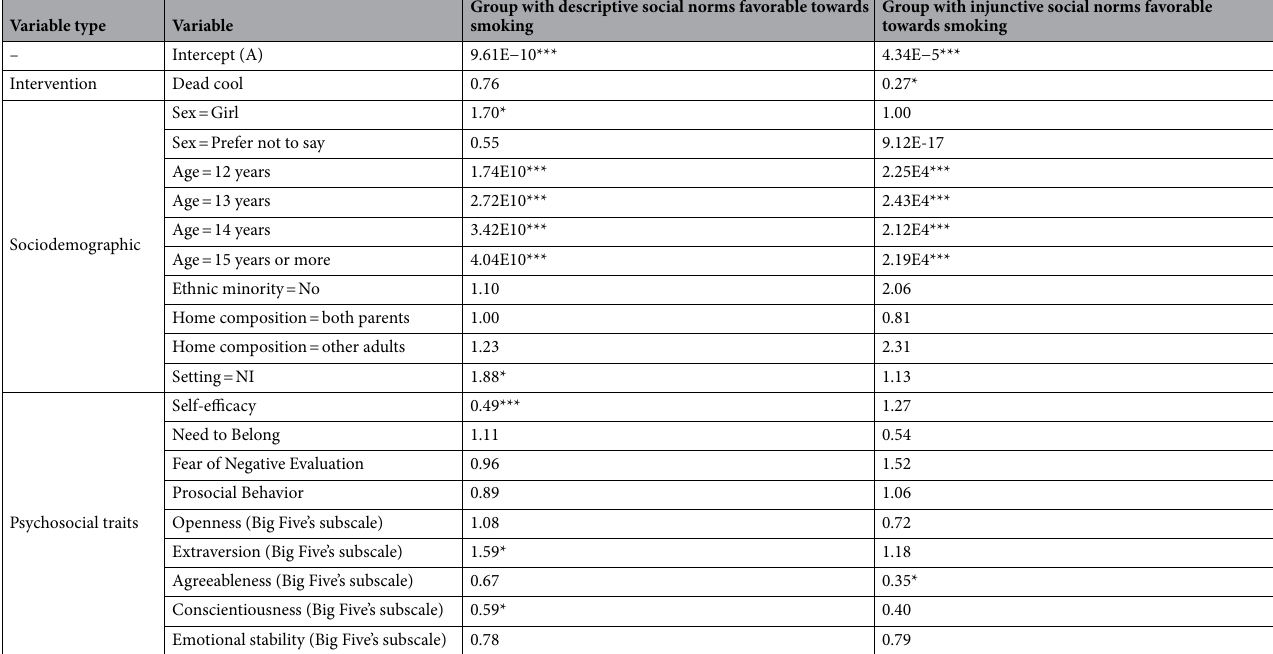
Table 2. Characterization of each latent group at baseline obtained in the LTA according to the intervention, sociodemographic and psychosocial traits conducting a multinomial statistical regression odds ratio estimates. The reference categories for each variable are as follows: group with both social norms against smoking for latent groups, boy for sex, 11 years for age, yes for ethnic minority, “single parent” for home composition, COL for setting, and ASSIST for intervention. *< 0.05 **< 0.01 ***<